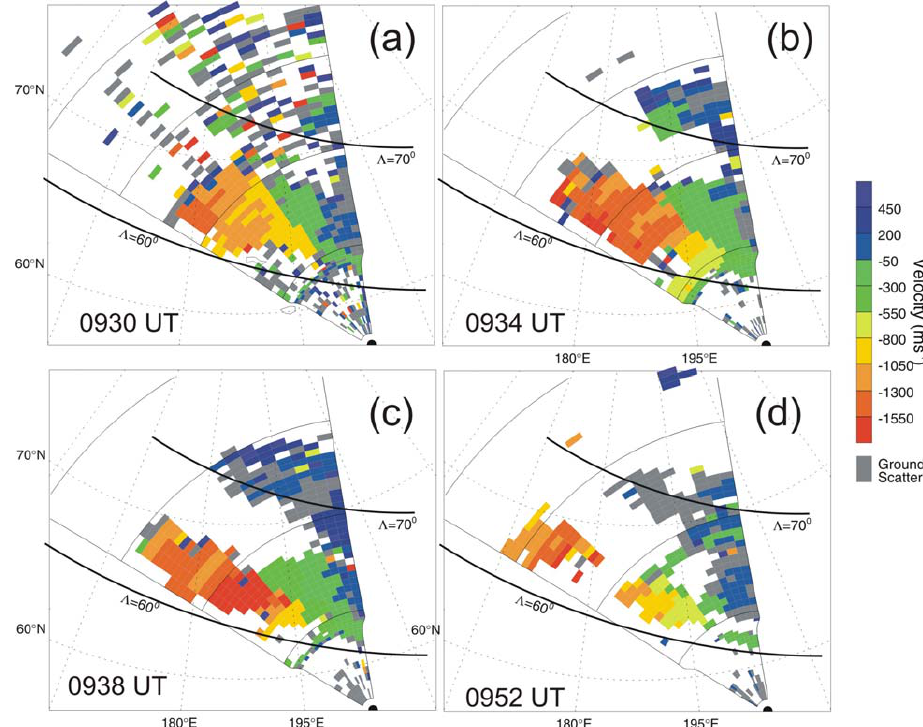
Fig. 10. King Salmon 1-min velocity maps illustrating the onset of very high-velocity echoes roughly along the L-shell directions between ∼ 09:34 and 09:38 UT. These echoes correspond to the extremely fast flow identified in Fig. 8c. The transition from the very high velocities to the background ones is seen well in the central beams as a sharp velocity magnitude decrease.